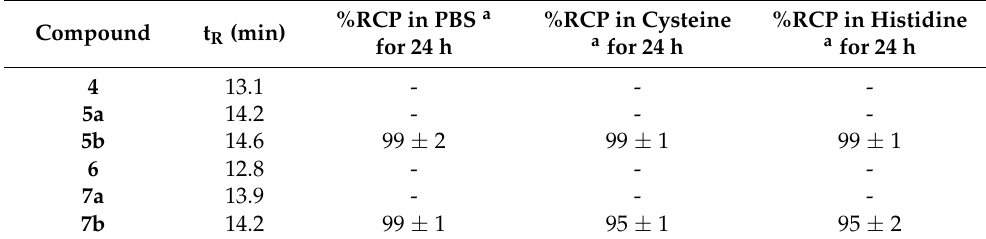
Table 1. Retention times (t R ) of ligands, Re- and 99m Tc-complexes, and RCP of 99m Tc-complexes in PBS, cysteine, and histidine after 24 h at 37 ◦